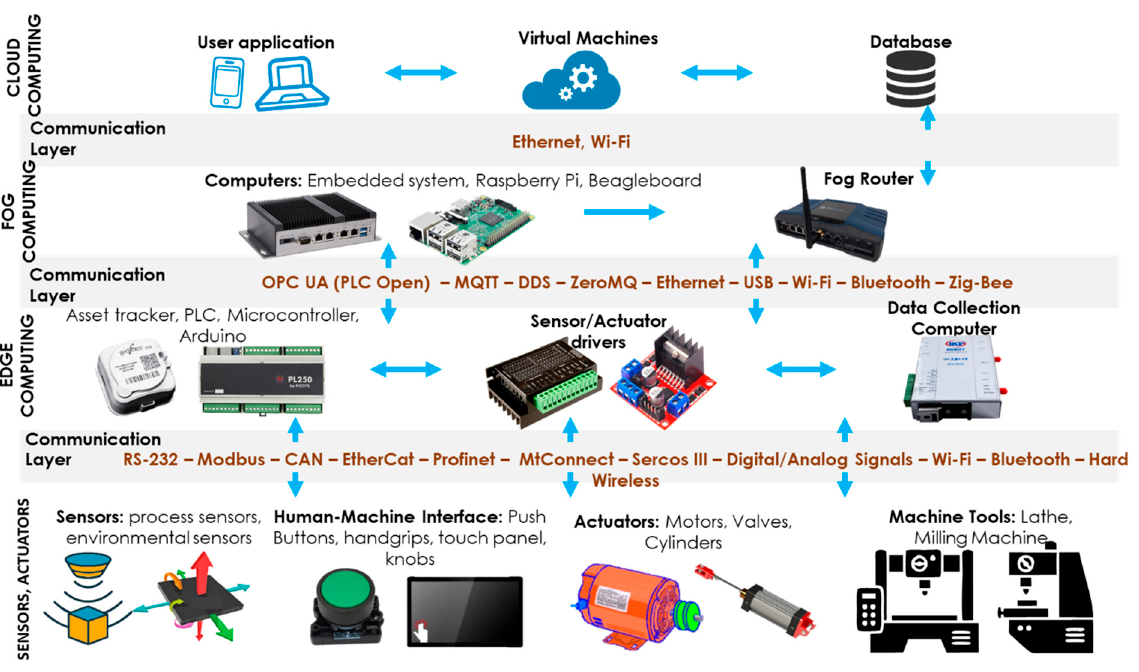
Figure 1. A map of technologies and protocols to facilitate